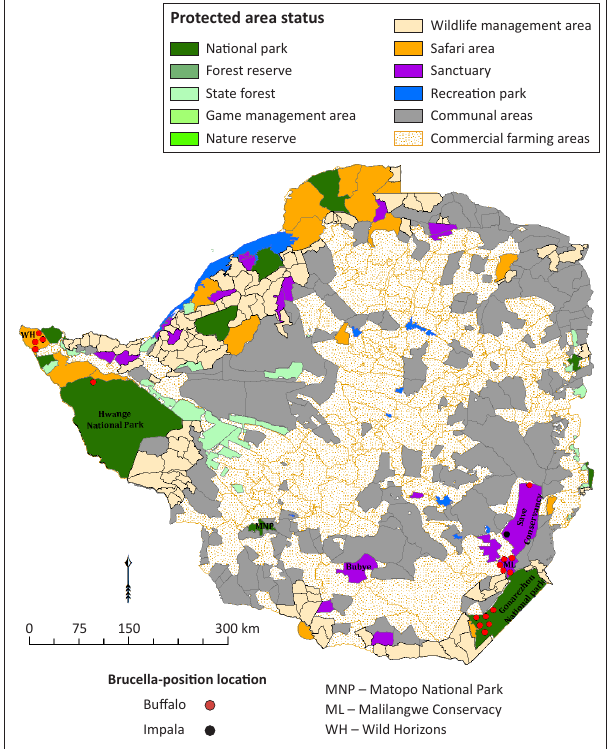
FIGURE 1: Map of Zimbabwe showing the land use classification, study sites and sites from which Brucella -positive samples were obtained.